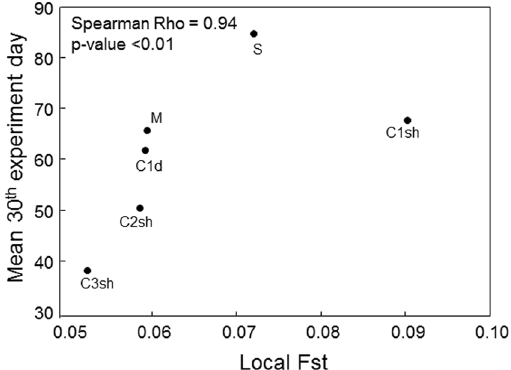
Figure 6. Affectation vs. local F ST . Relation between affectation (mean percentage of necrosis on the last day of the experiment) and local F ST . The points and their labels are shown. The Spearman Rho statistic and its corresponding p-value are also presented. M: Medes; C1sh, C2sh and C3sh: Calanques1, 2 and 3 shallow; C1d: Calanques 1 deep; S: